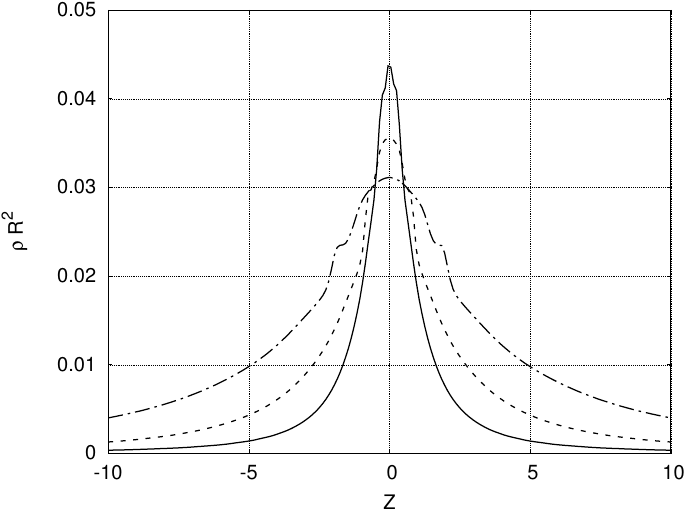
Figure 4. Normalized density ρ · R 2 along lines across the equator for 3 distances of the lines from the center of the star. Solid line—2; dashed line—4; dashed–dotted line—8 stellar radius. All the geometrical values are expressed in units of radius of the star at the pole R pole . T ef f corresponds to the sound velocity v 2 s = 4 × 10 − 3 . ˙ m 0 = 2.4 × 10 − 2 .